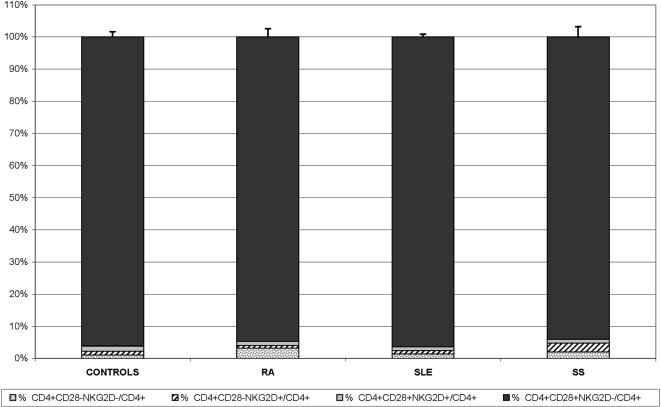
Surface phenotype of CD4 T cells with respect to NKG2D and CD28.This, more global figure, analyses the ratio of CD4+ T cells harbouring or not CD28 and/or NKG2D, or not. None of the differences is statistically significant.